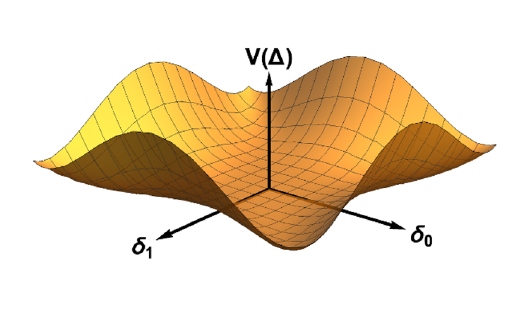
Figure 4 . Triplet quartic potential with a classically stable vacuum in arbitrary units. We used the values for λ 1 and λ 2 at M ∆ = 10 9 GeV in the case of Y ∆ = 1 . Close to the minimum the mass term dominates and a non-zero expectation value occurs when the interaction with the doublet is taken into